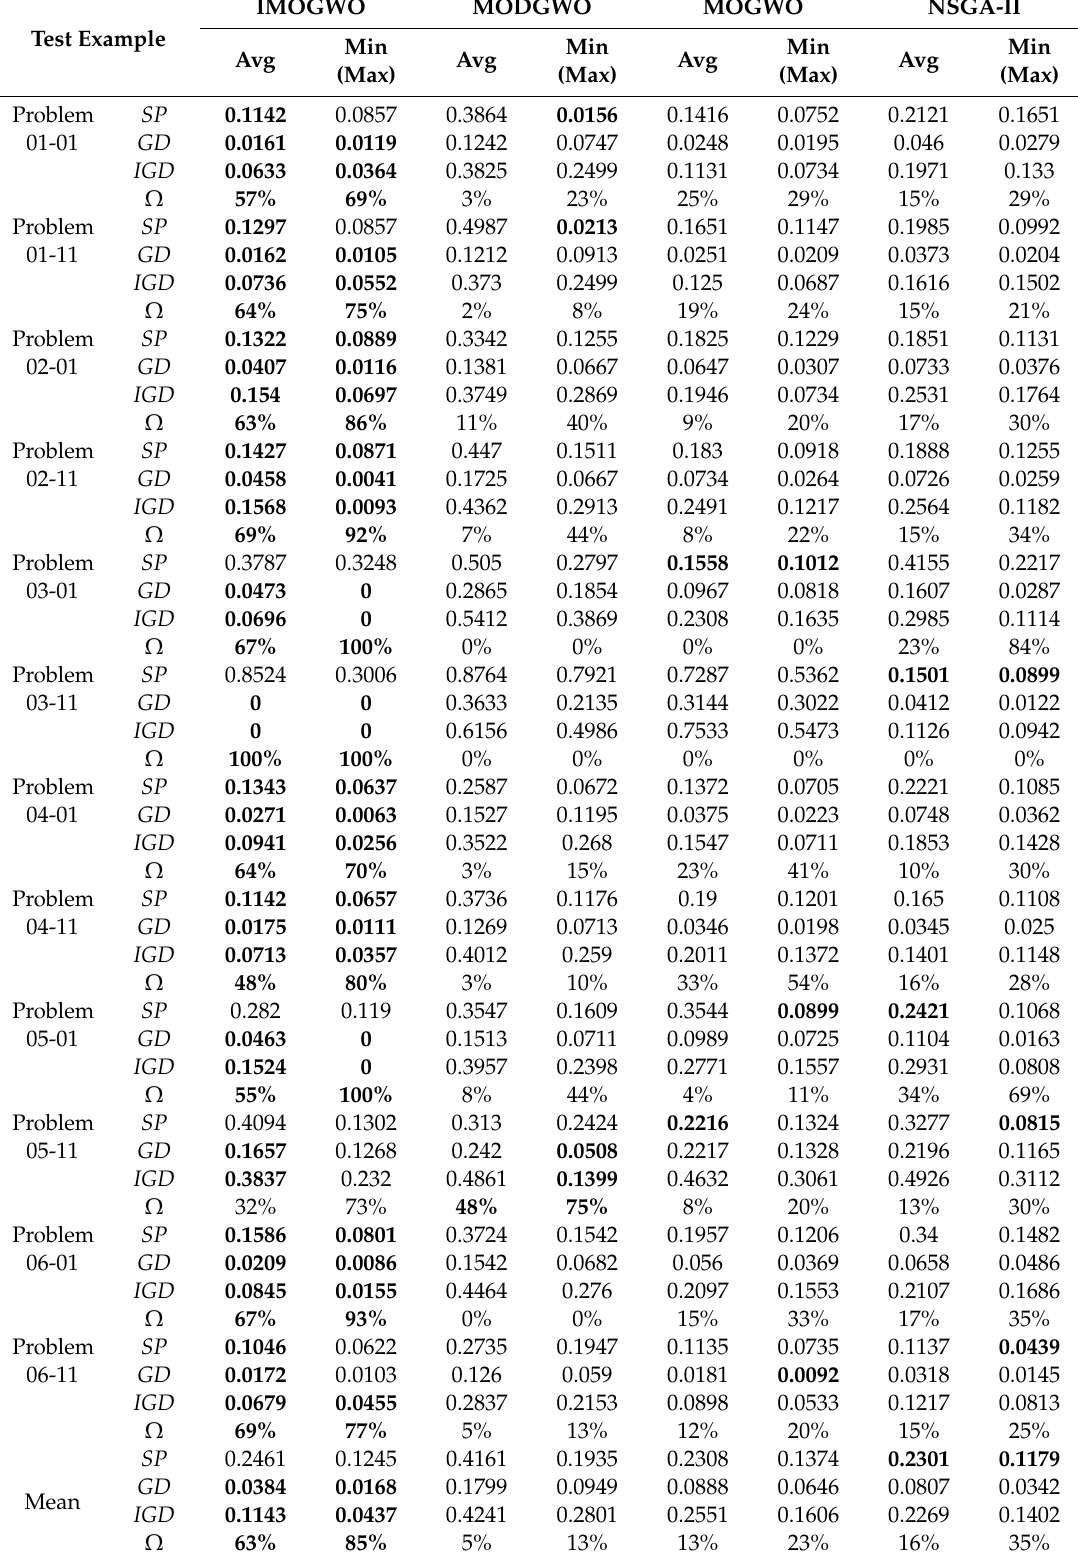
Table 8. Experimental results’ comparison of four algorithms with three